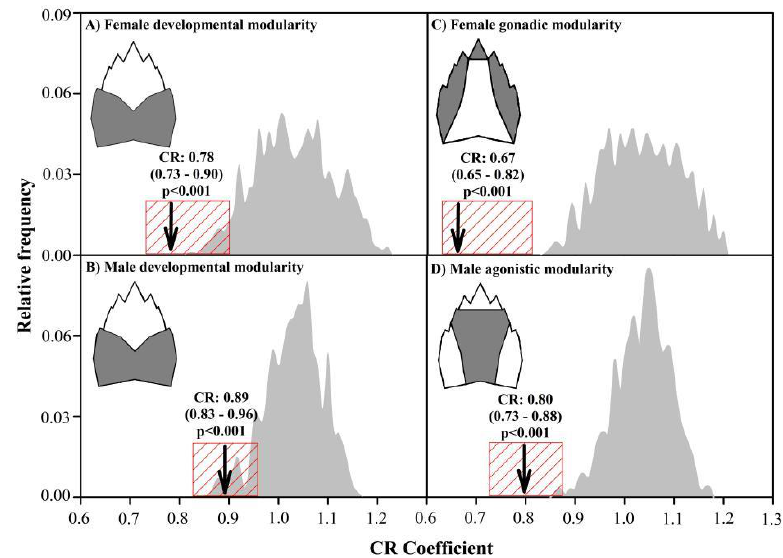
Figure 5. Modularity test showing the variations in the expression of the developmental modularity of females ( A ) and males ( B ) with respect to the best-supported models of gonadic modularity in females ( C ) and agonistic modularity in males ( D ) of A. araucaniensis . The mean and distribution of the observed partitions (arrow and red box, respectively) were contrasted with a distribution of arbitrary partitions (grey curves).